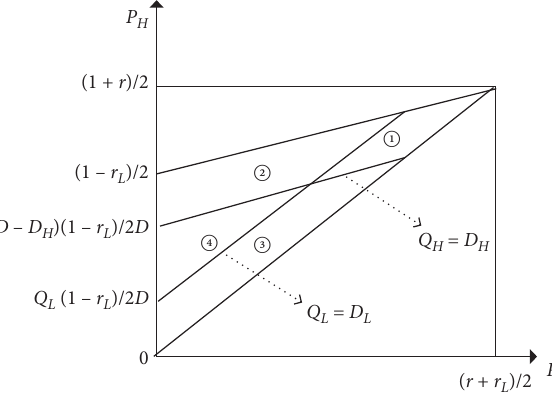
Figure 3: Supply and demand relations for fresh